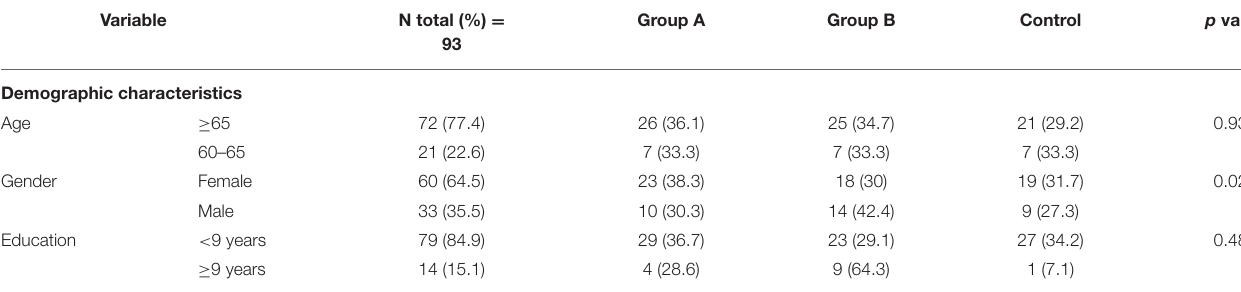
TABLE 3 | Demographic characteristics of group A, B, and Control.